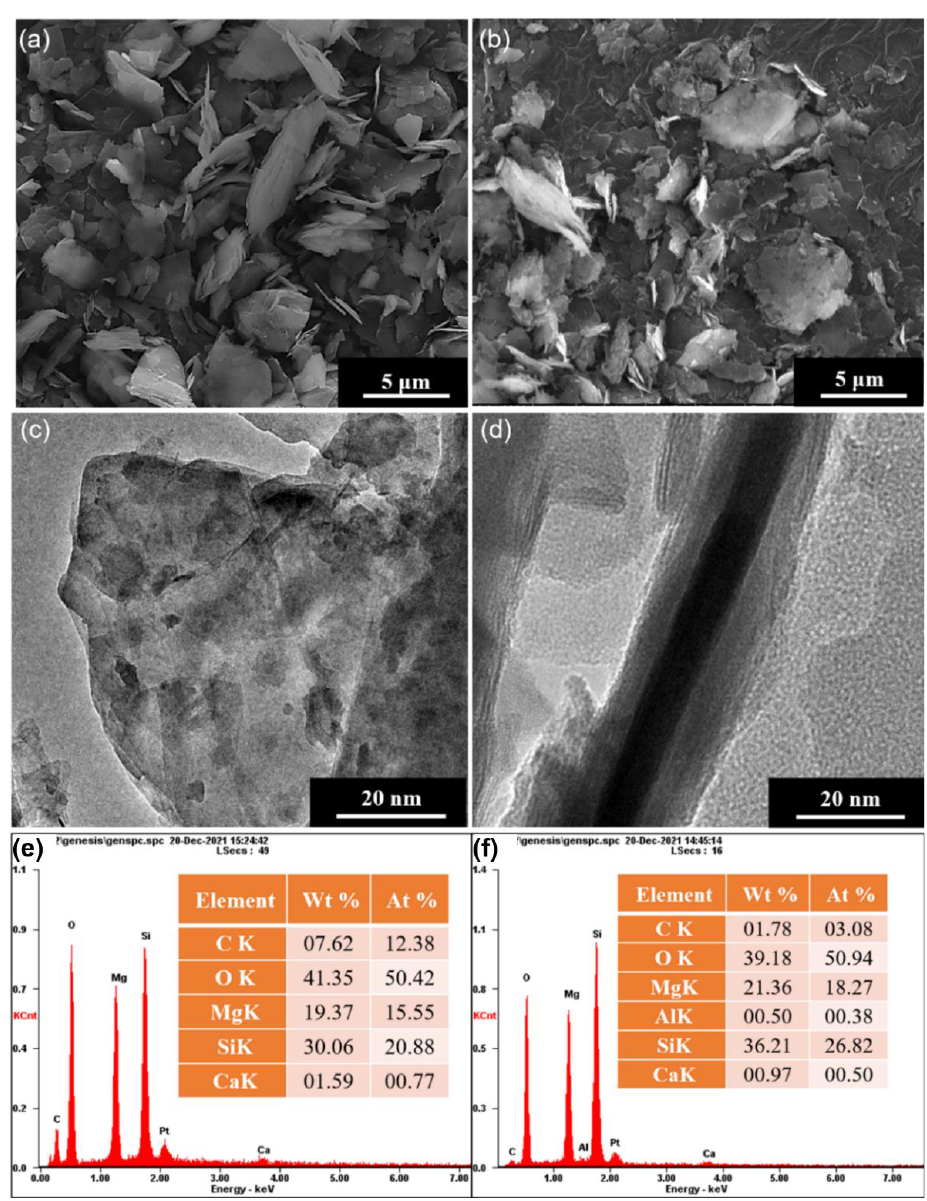
Figure 2. Characterization of talc nanosheets: SEM morphologies of unmodified talc ( a ) and modified talc ( b ); TEM morphologies of modified talc ( c , d ); EDS element analysis of the unmodified talc ( e ) and modified talc ( f ).